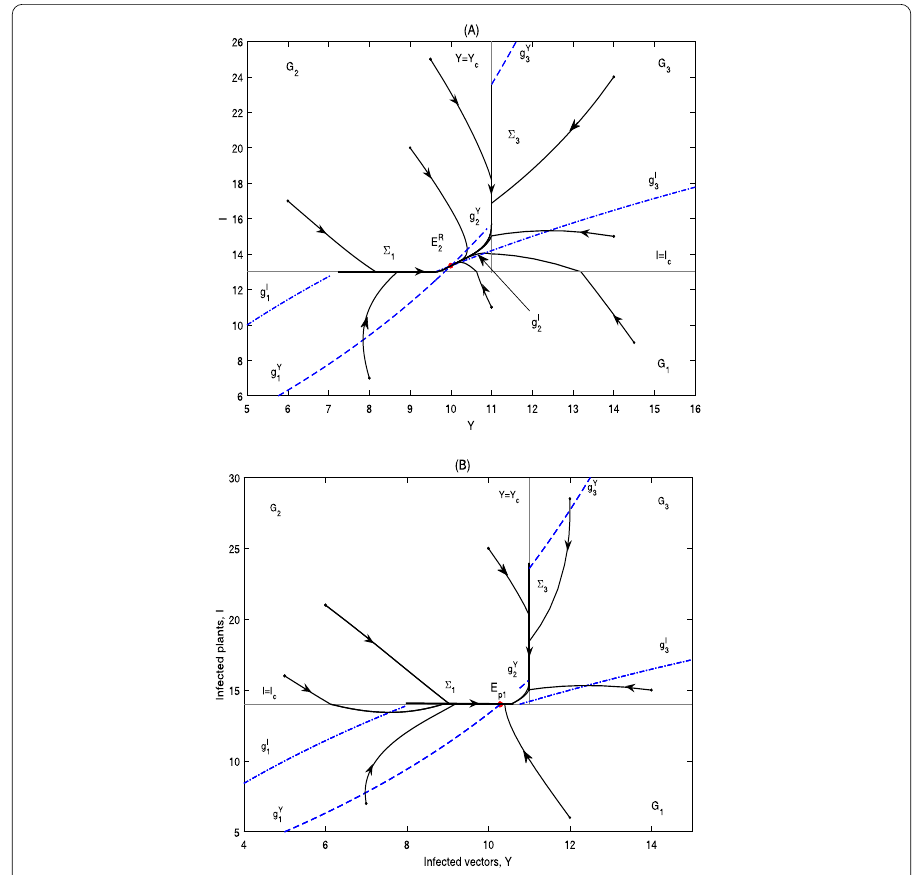
Figure 10 Global dynamics in Case C.1. ( A ) E R 2 is globally asymptotically stable. Y c = 11, I c = 13. ( B ) E p 1 is globally asymptotically stable. Y c = 11, I c =